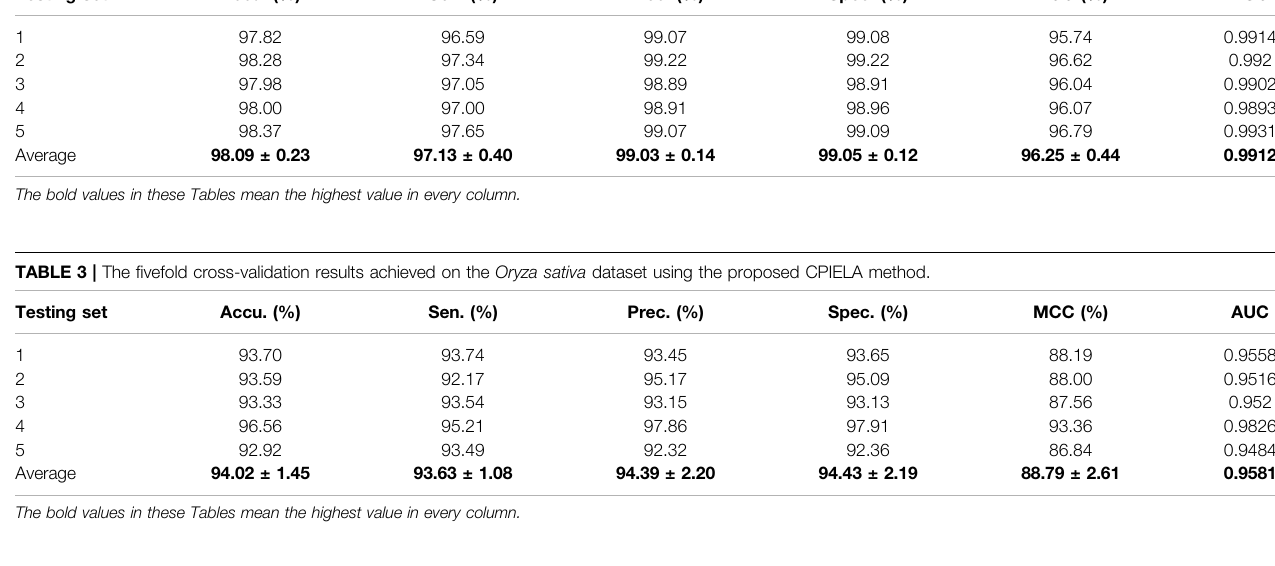
TABLE 2 | The fi vefold cross-validation results achieved on the Zea mays dataset using the proposed CPIELA method. Testing set Accu. (%)